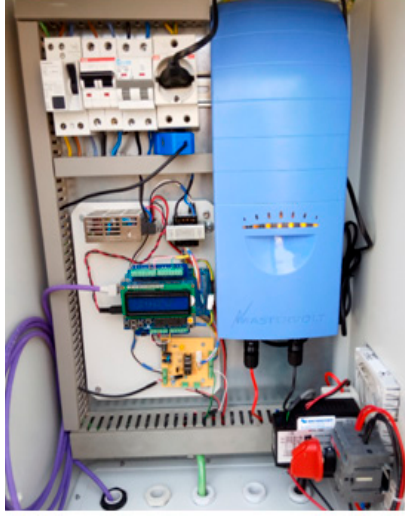
Figure 6. Electrical equipment.